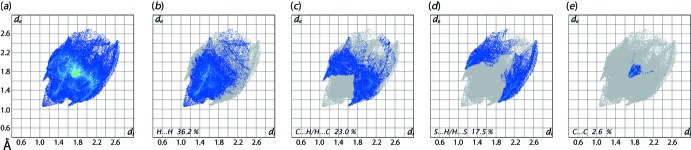
(a) The full two-dimensional fingerprint plot for (I) and fingerprint plots delineated into (b) H⋯H, (c) C⋯H/H⋯C, (d) S⋯H/H⋯S and (e) C⋯C contacts.